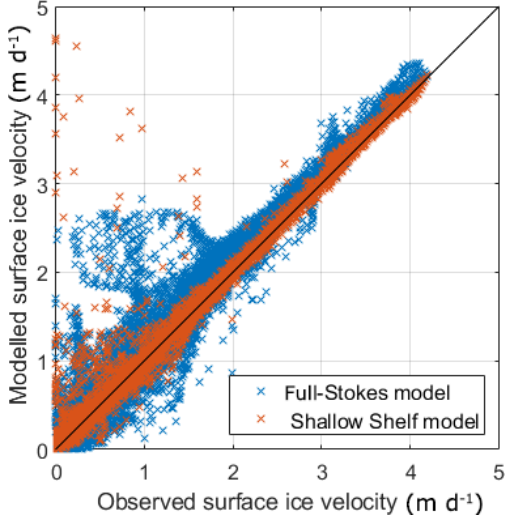
Figure A1. Comparison between observed surface ice velocities, obtained from the MEaSUREs version 2 dataset (Rignot et al., 2017, 2011b; Mouginot et al., 2012), and modelled ice velocities using either the 3-D model (Sect. 2.1, blue crosses) or the Úa model (red